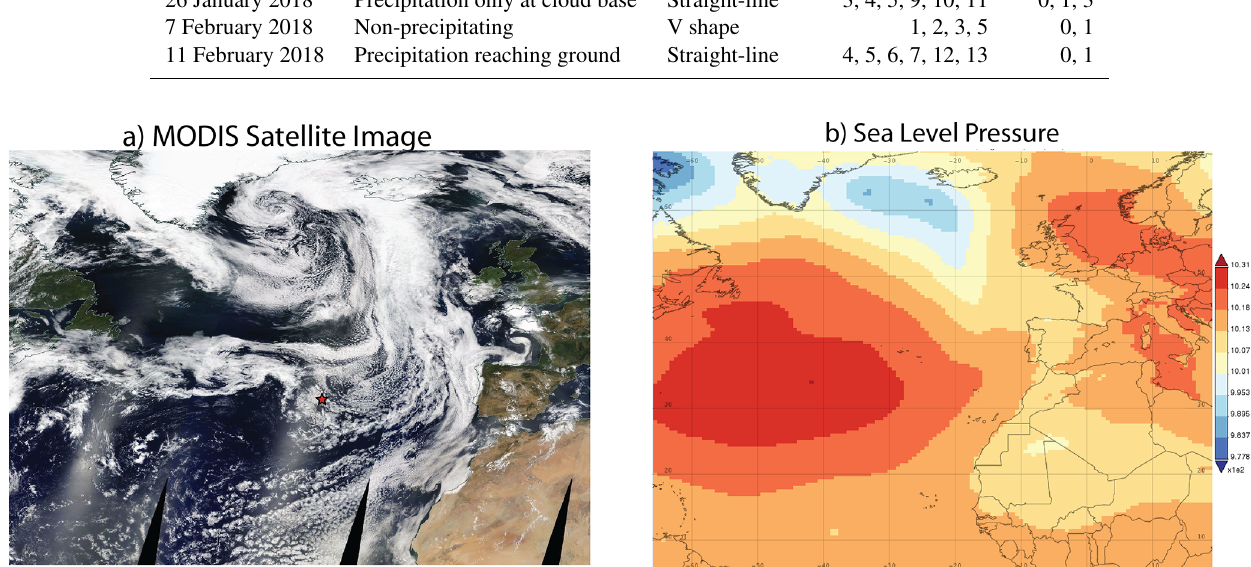
Figure 2. (a) The real color satellite image of the ENA region on 18 July 2017 from MODIS. The small red star marks the location of the ARM ENA site on Graciosa Island. (b) The averaged sea level pressure (SLP) of the ENA region on 18 July 2017 from the MERRA-2